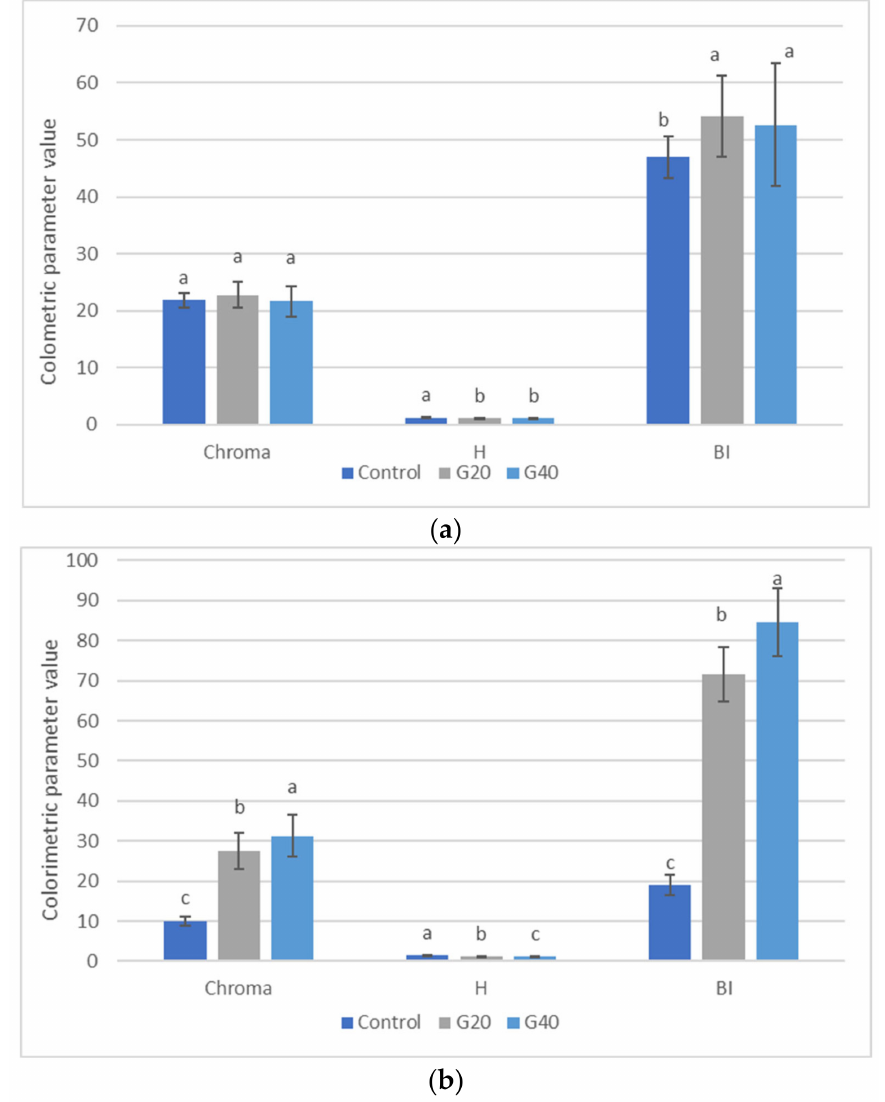
Figure 3. Chroma, hue angle, and browning index (BI) in external ( a ) and internal ( b ) ciabatta bread and enriched ciabatta bread (with 20% and 40% goji puree). Differences between samples were evaluated by one-way ANOVA followed by Tukey’s test. Results followed by different letters are significantly different at ** p <